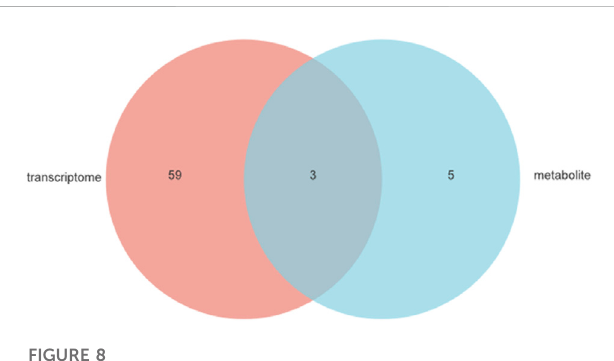
FIGURE 8 Venn diagram: Pathways with signi fi cant enrichment of genes and